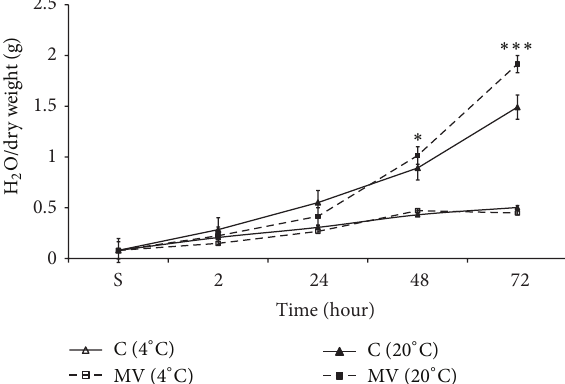
Figure 6: Time-dependent changes in seed hydration during 72 hours of incubation in SMF (2.5mT) treated (gray column) and nontreated Sham (clear column) DW in cold (4 ∘ C; clear/grey with no pattern markings) and warm (20 ∘ C clear/grey with horizontal pattern markings) conditions. The time (in hours) of seeds incu- bation on abscissa and the value of seed hydration (mg of H 2 O for 1mg of dry weight) on ordinate are presented. The results are shown as mean ± SEM ( 𝑛 = 300 ) from three independent experiments, 100 seeds from each experiment. ∗ 𝑃 < 0.05 , compared with Sham, ∗∗ 𝑃 < 0.01